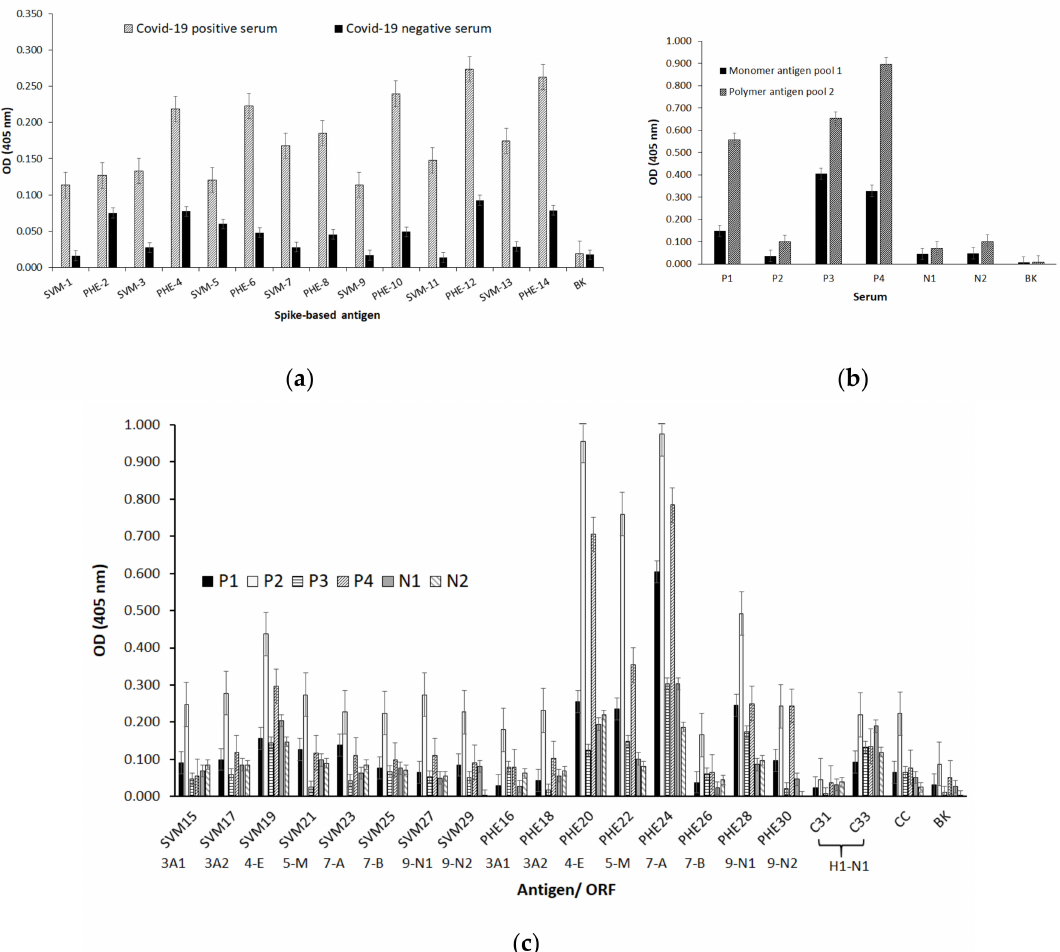
Figure 3. Human serum from two PCR diagnosed patients´ immuno-reactivity for synthesized epitope-peptides based on the SARS-CoV-2 spike protein. ( a ) Molecular recognition of S-based epitope-peptides presented as monomer (SMV) and polymer (PHE) forms. ( b ) Serum from four patient’s PCR positive diagnosed (P) strongly reacts with equimolar pooled S-based polymer epitopes while two negative diagnosed (N) had no reactivity. ( c ) The same panel of serum from four patients PCR positive diagnosed (P) strongly reacts with individual E, M, N, ORF3a, ORF3b, ORF7a, 7b-based epitopes presented as monomer (SVM) and polymer (PHE) forms while two negative diagnosed (N) had no reactivity. Antigen controls were coded as C31 and C33 representing two influenza virus A H1N1 epitope-peptides. CC represents a reagents control and BK the